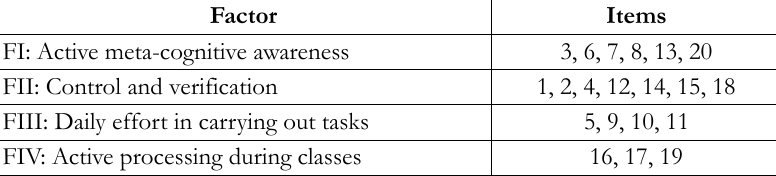
Table 2. Dimensional factors of Torres’ questionnaire on self-regulation for academic learning